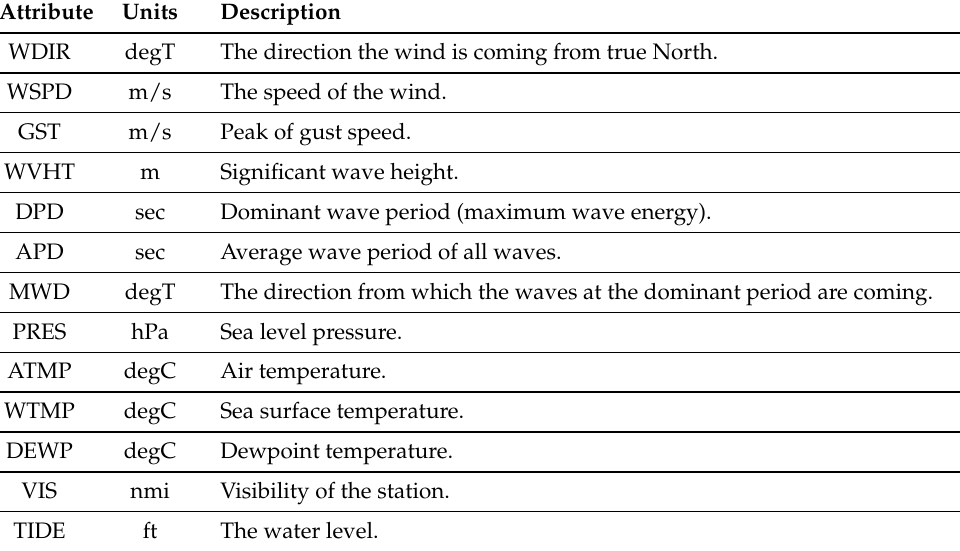
Table 1. Measurements descriptions and units of each meteorological variable or attribute collected by the buoys (a detailed description can be found in NDBC website [60]).